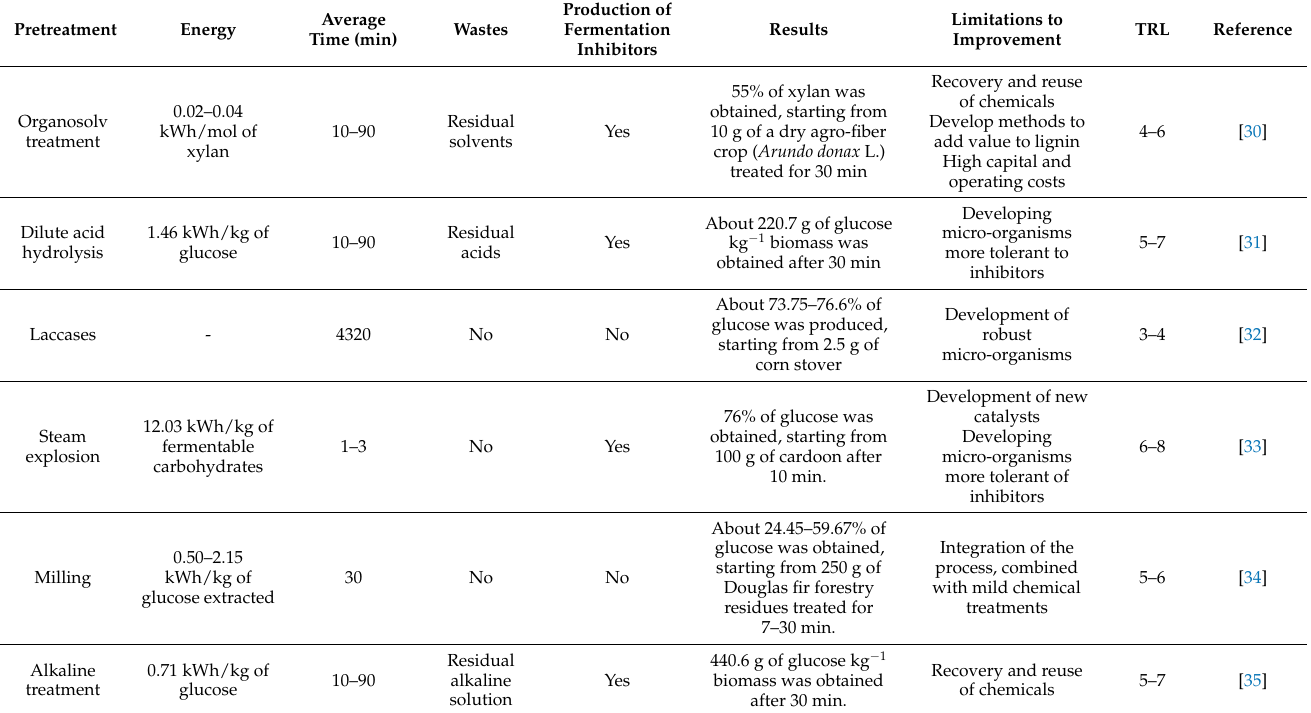
Table 1. Conventional